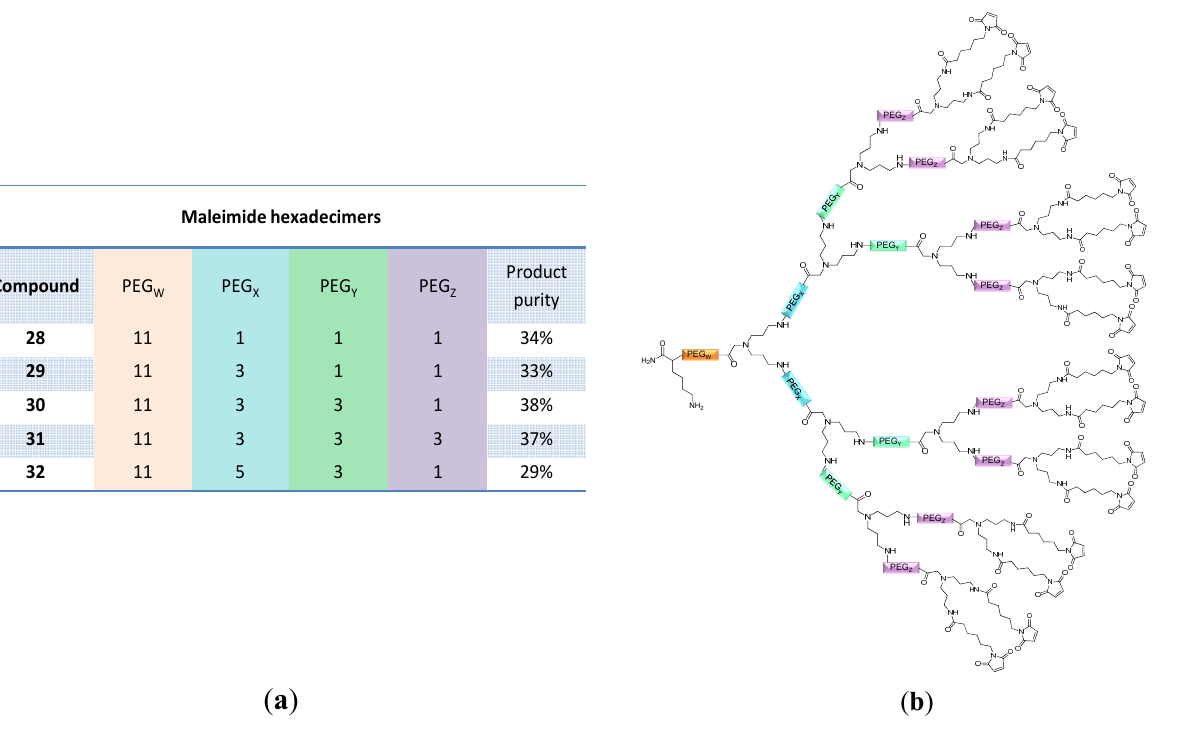
Figure 6. Obtained product purities of the cleaved raw materials (a); and schematic depiction of the structures of hexadecimeric maleimides 28 – 32 ( b ). Product purities were determined by analytical